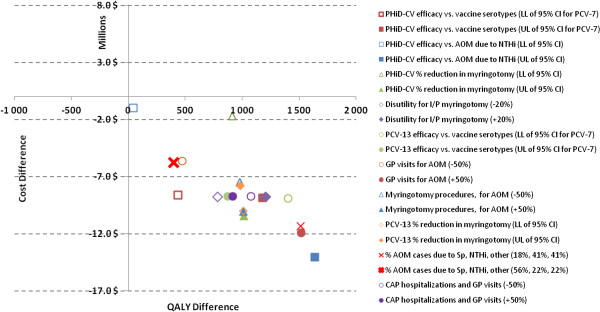
One-way sensitivity analysis. AOM = acute otitis media, CAP = community-acquired pneumonia, CI = confidence interval, GP = general practitioner, I/P = inpatient, LL = lower limit, NTHi = non-typeable Haemophilus influenzae, PCV-7 = 7-valent pneumococcal conjugate vaccine, PCV-13 = 13-valent pneumococcal conjugate vaccine, PHiD-CV = pneumococcal non-typeable Haemophilus influenzae Protein D conjugate vaccine, Sp = Streptococcus pneumoniae, UL = upper limit.